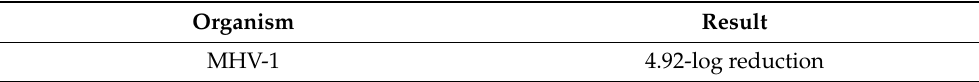
methods for 10 min of exposure time; n = 3.